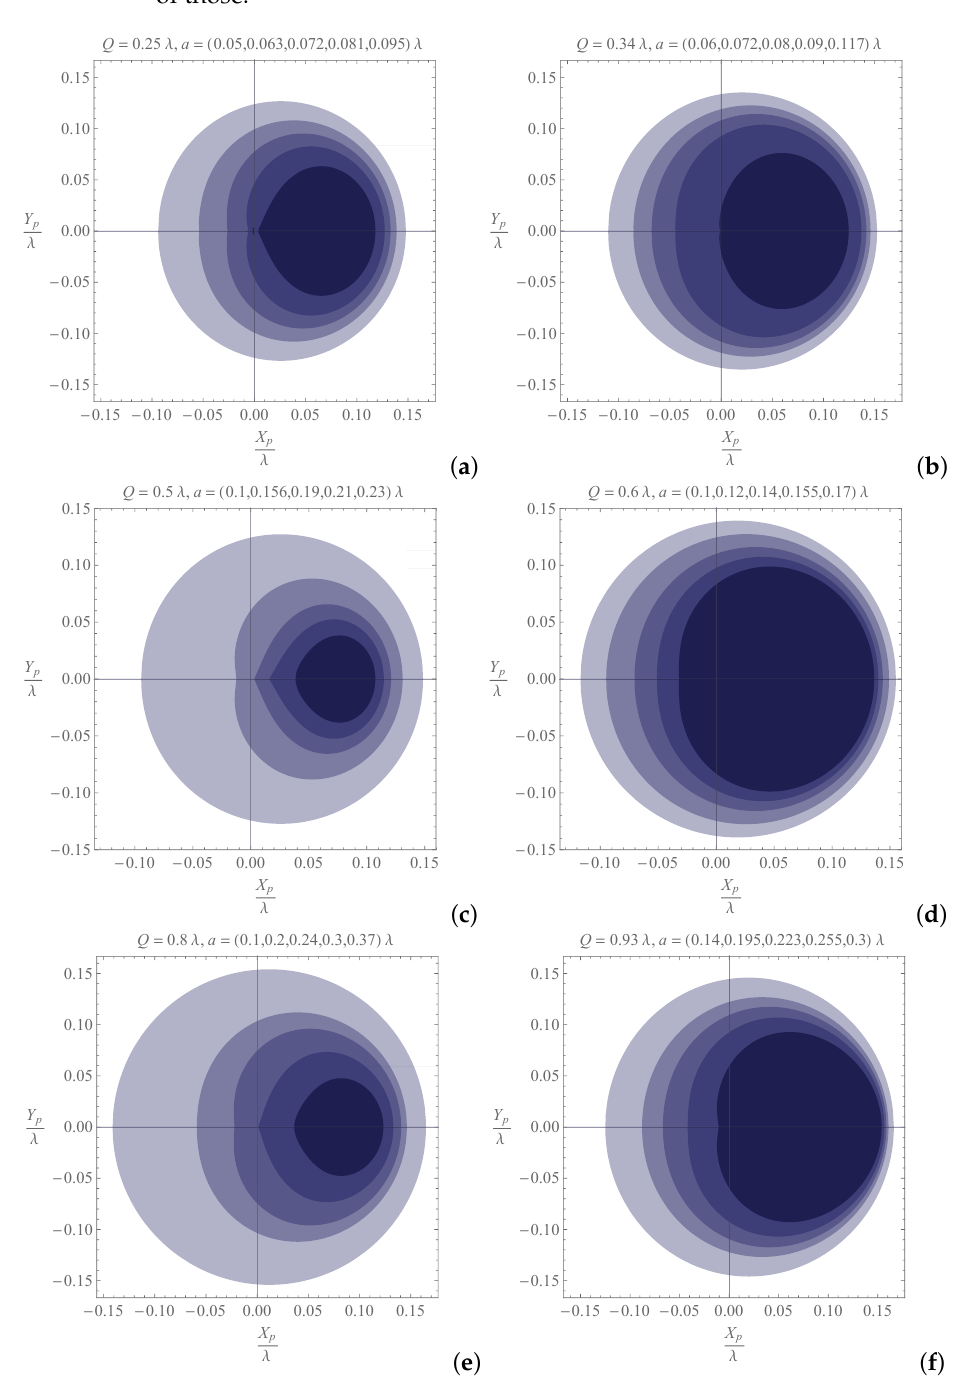
Figure 6. The shadow of the RCWBH for a (cid:54) = 0, plotted for λ = 10 and r o = 5 λ . Each diagram corresponds to a fixed value of Q and five values of a , which are sorted from the largest to the smallest parametric curve. The figures are scaled in order to have an approximate circular shape for the smallest a in each of the